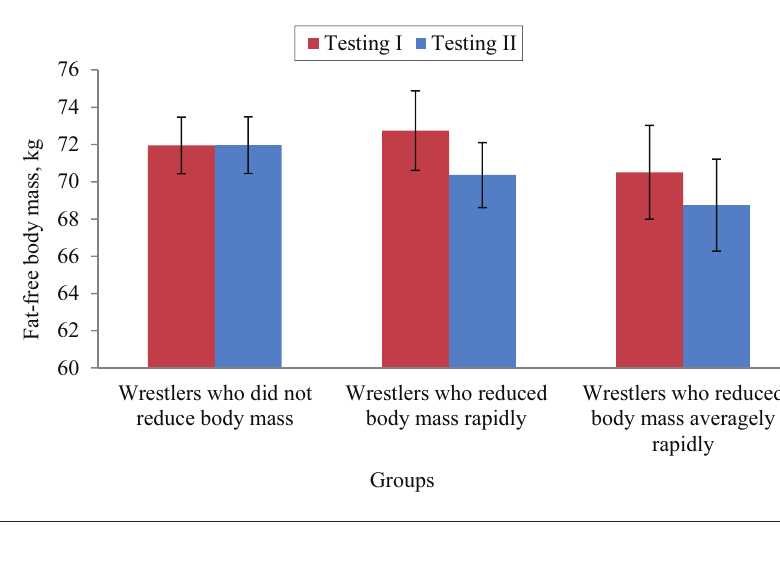
Figure 3. Wrestlers’ fat-free body mass changes